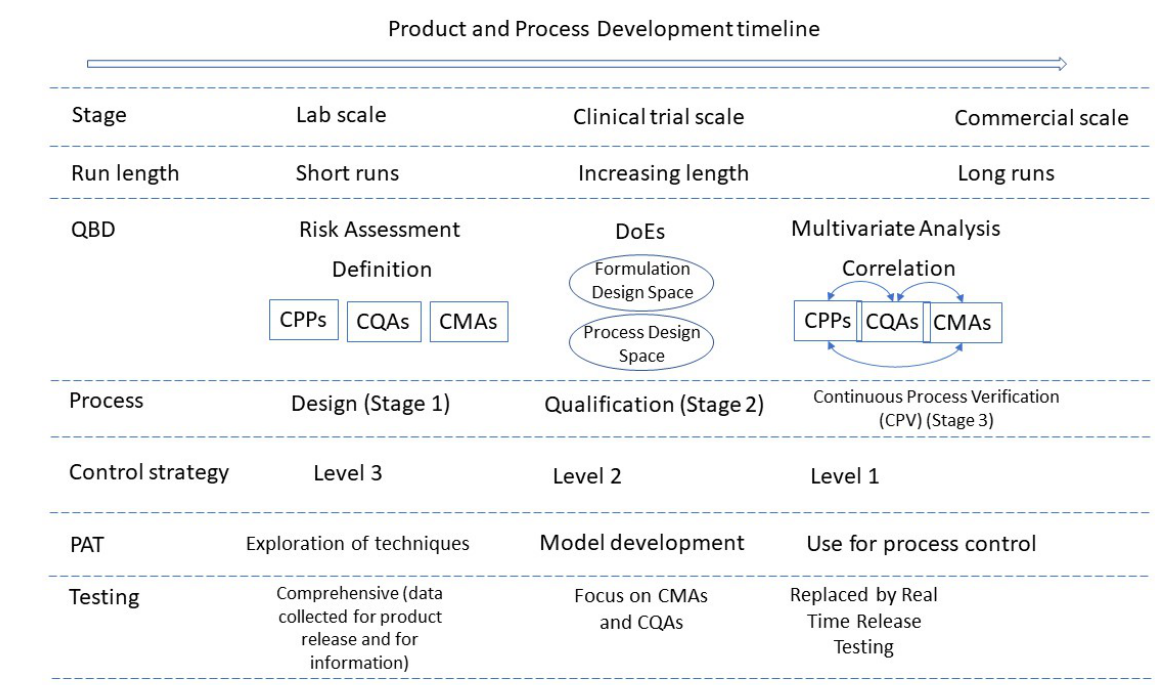
Figure 2. Schematic of continuous manufacturing process development. Adapted from [68], Pharmaceutics 2021. DoEs = Design of Experiments. Schematic assumes scale-up is achieved by running CM process for longer periods and technology transfer is avoided by using same equipment throughout development and into commercialisation.